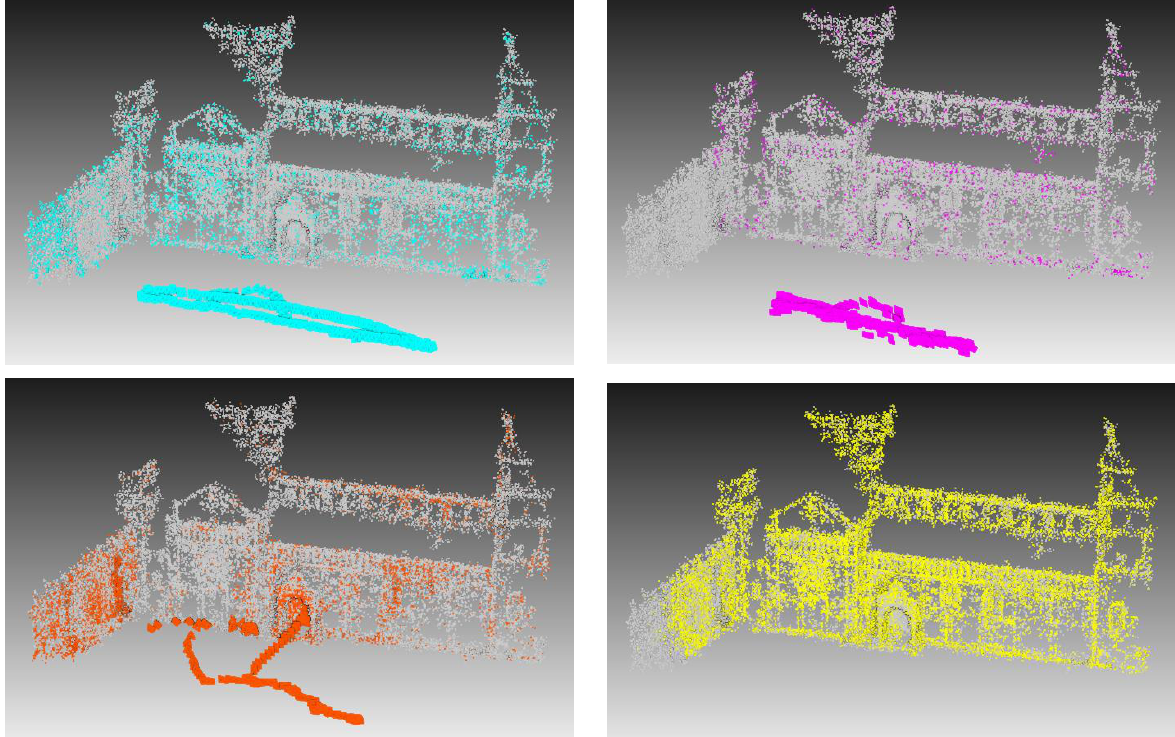
Figure 6: The sparse point cloud of the Piazza Duomo dataset. The points are coloured according to the smartphone they are triangulated from (Table 1); in yellow the points triangulated from images belonging to multiple